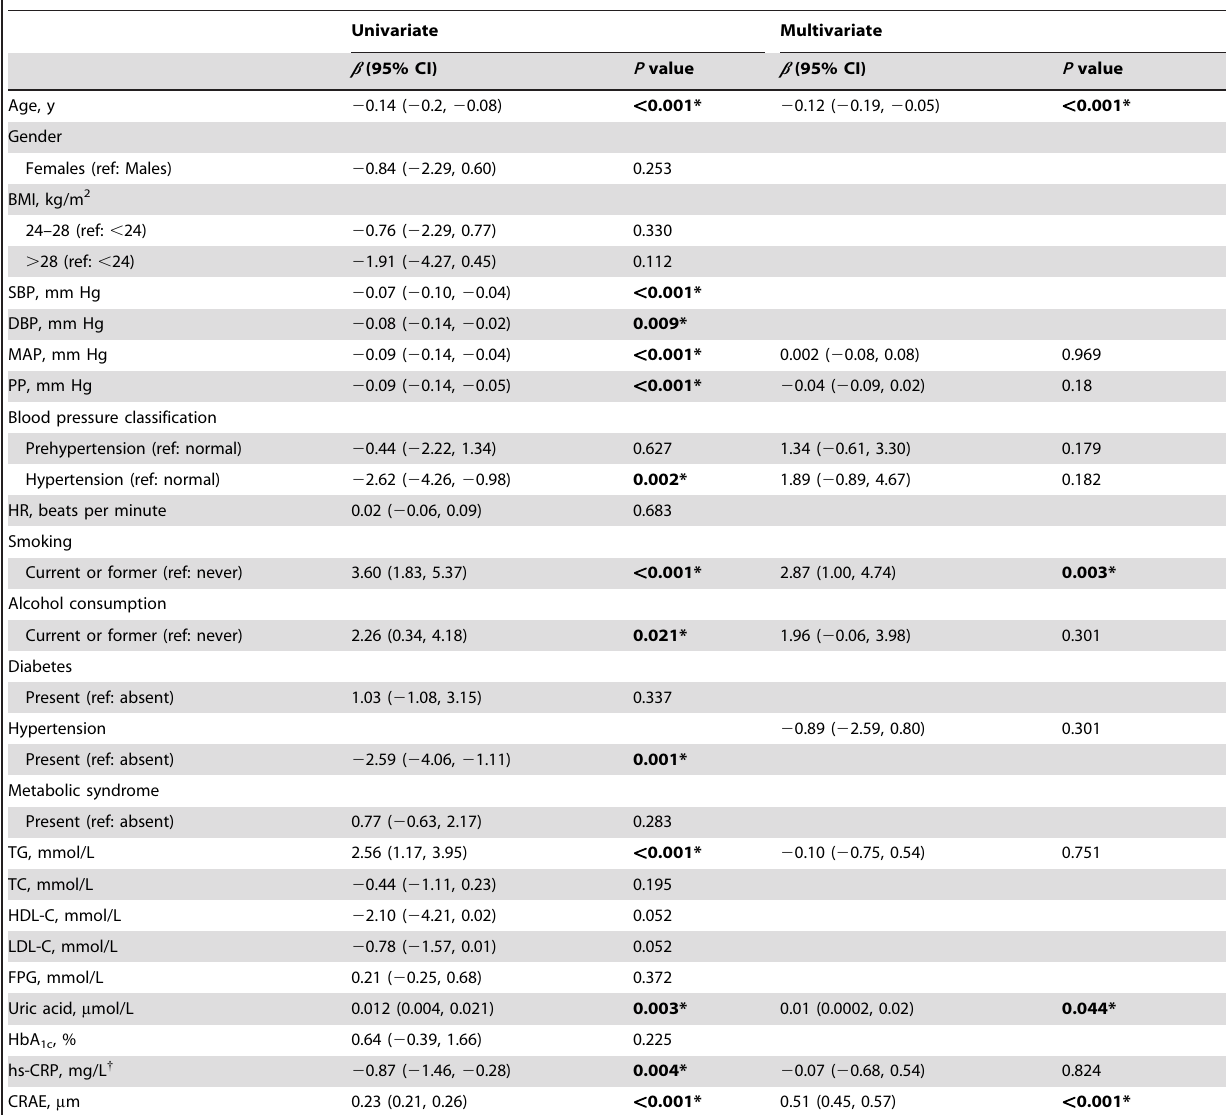
Table 4. Simple and multiple linear regression analyses for